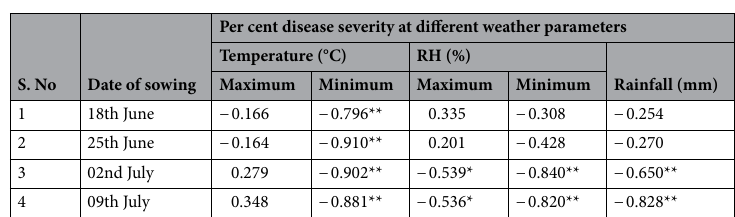
Table 4. Correlation matrix between weather parameters and per cent disease severity in different date of sowing during Kharif, 2019. *and **Represent significant at 5 and 1%, respectively.